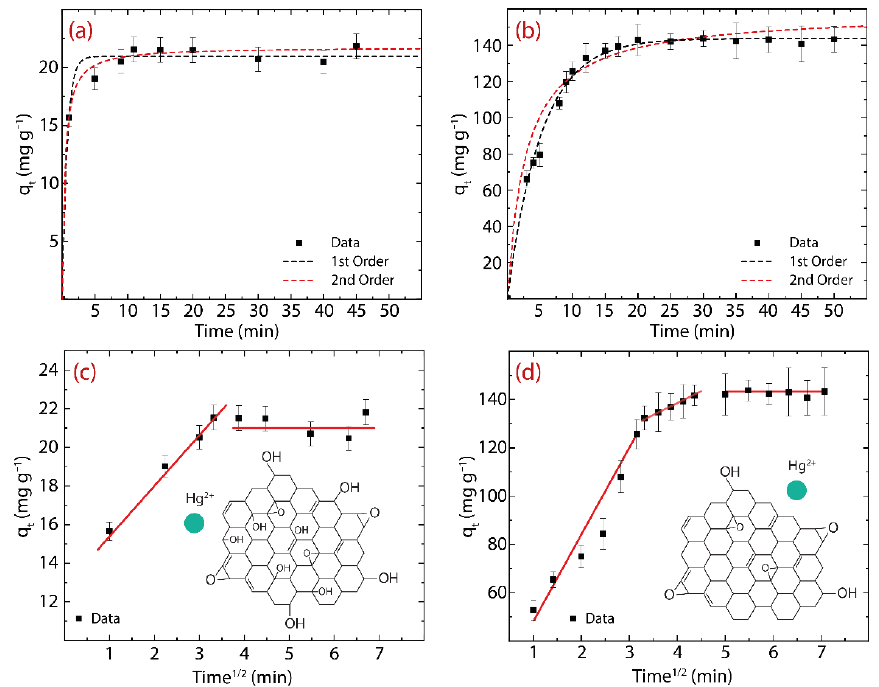
Figure 5. Pseudo-first- and pseudo-second-order models as well as the intraparticle diffusion (IPD) model of the adsorption of Hg(II) on ( a , c ) GO and ( b , d ) rGO. IPD study shows different regions of linearity. The initial concentration is 150 mg L −1 .